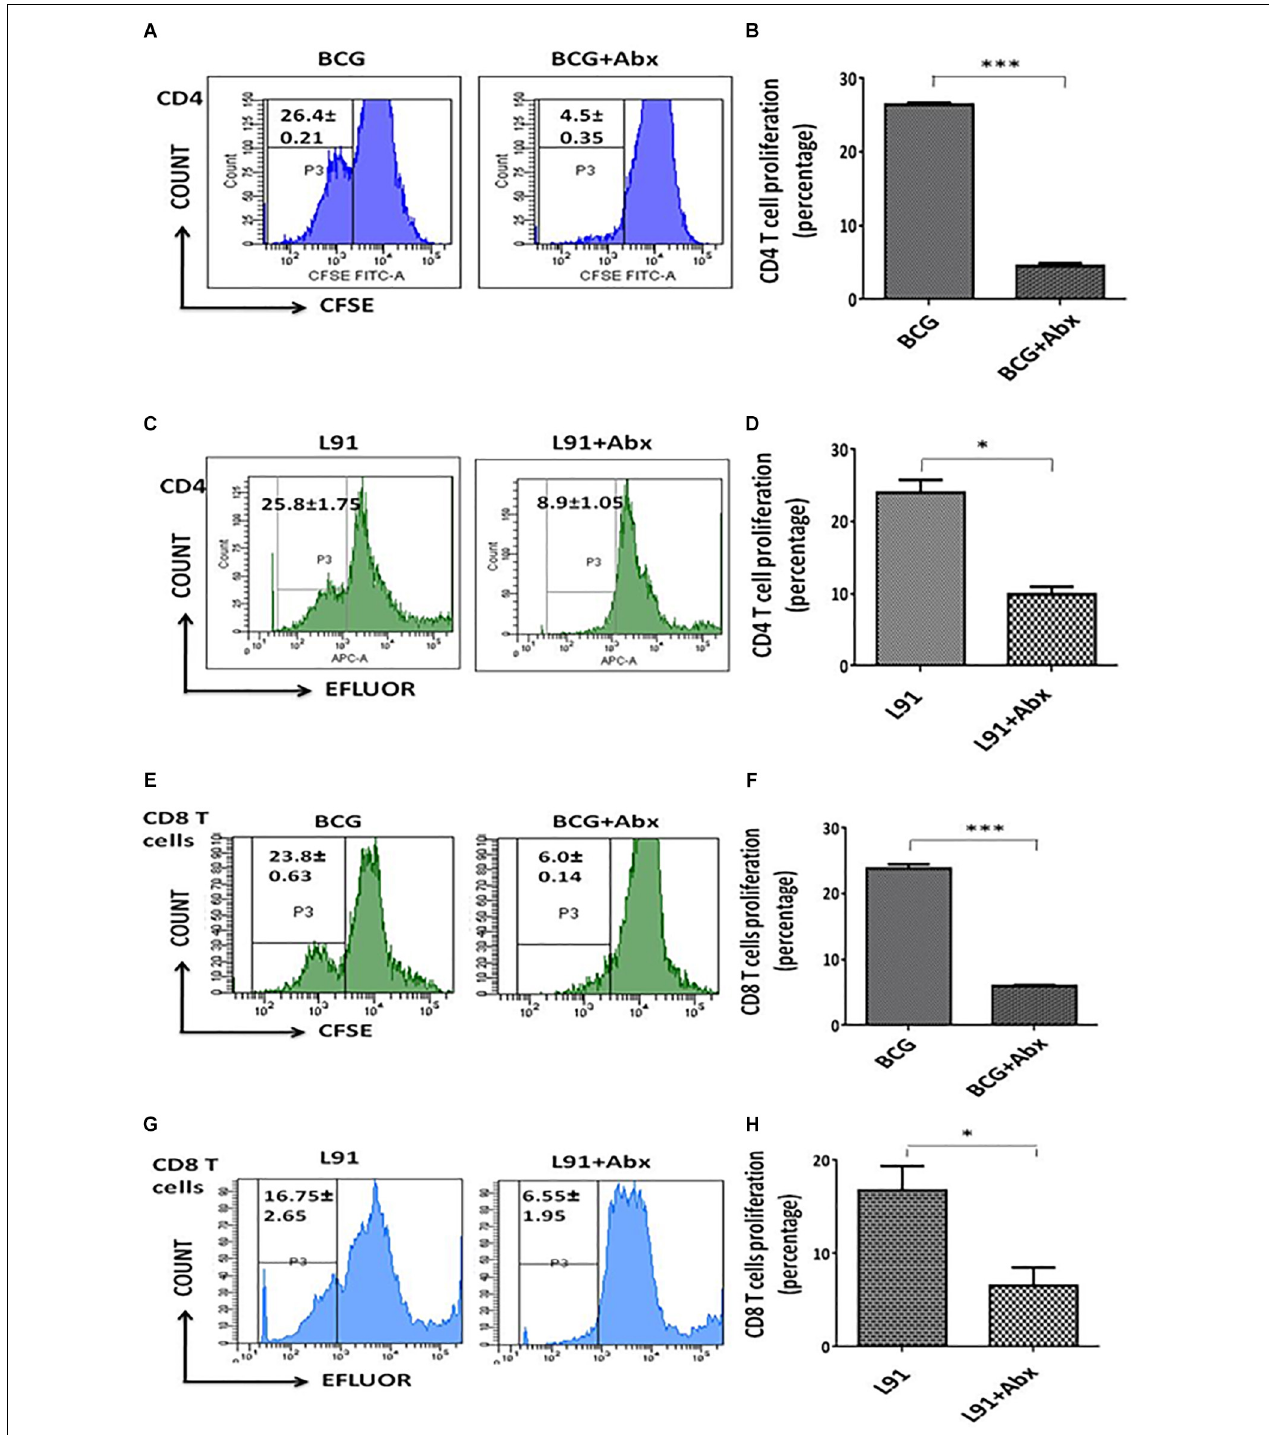
FIGURE 2 | Dysbiosis of gut microbiota in vaccinated animals hampered the proliferation of T cells. After 21 days of Mtb exposure, the lungs were isolated from the BCG and L91 vaccinated and Abx treated mice. Single cell suspensions of lung cells were prepared and equal number of cells in both groups were stained with CFSE/efluor dye. Subsequently, the cells were in vitro stimulated with PPD for 48 h. Later, the cells obtained from (A,B,E,F) BCG and (C,D,G,H) L91 vaccinated mice were subsequently gated on (A–D) CD4 + T and (E–H) CD8 + T cells and monitored for the proliferation. The number in histogram indicates the percent of (CFSE/efluor) lo population. Data shown as mean ± SEM are the representative of 2 independent experiments ( n = 3–4 animals/group). * p < 0.05, *** p < 0.001.